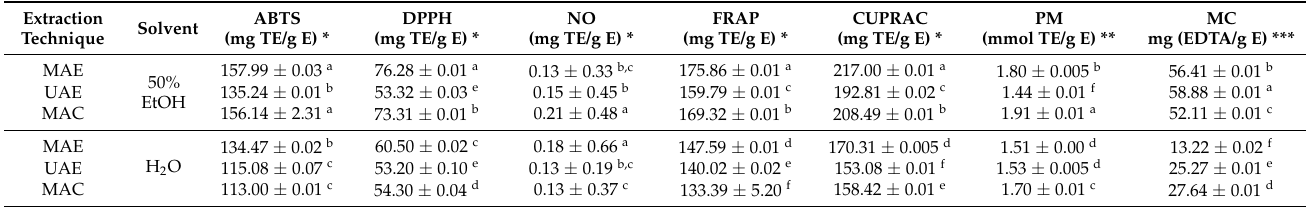
Table 3. Antioxidant properties of fresh fruit elderberry